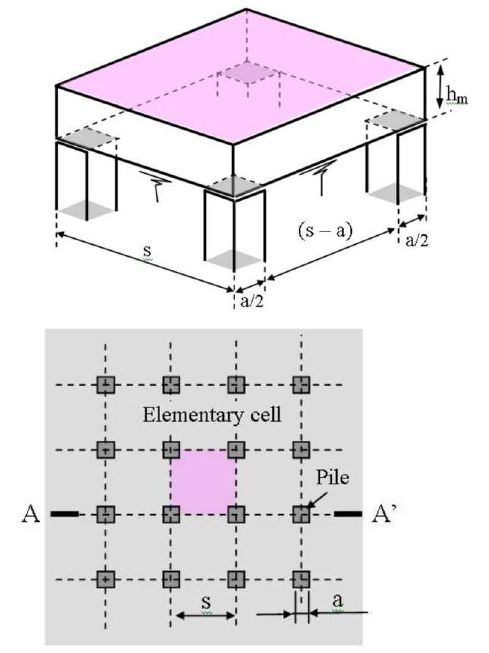
Fig. 1. Geometry of the numerical test, granular layer and network of piles [2]